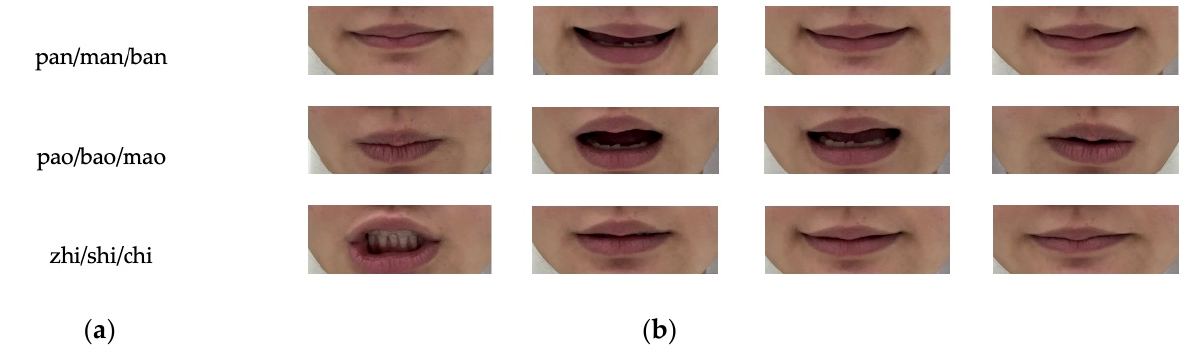
Figure 11. ( a ) Pinyin with similar lip movement ( b ) corresponding lip movement.